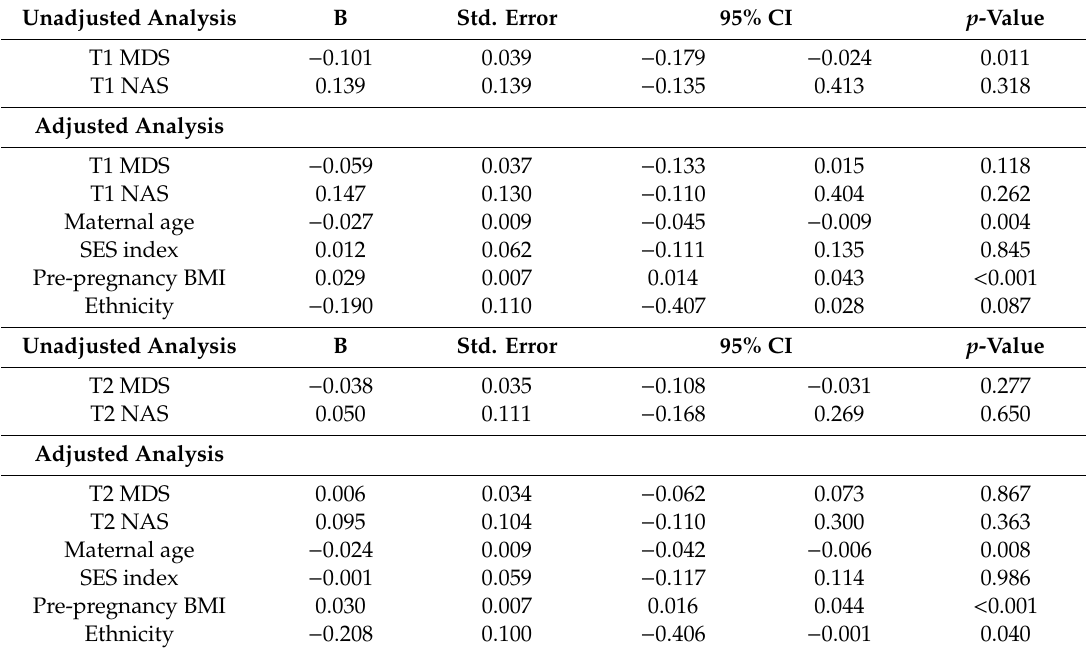
Table 3. Main e ff ect of the maternal MDS and NAS in early and mid-pregnancy on the third trimester HOMA-IR.